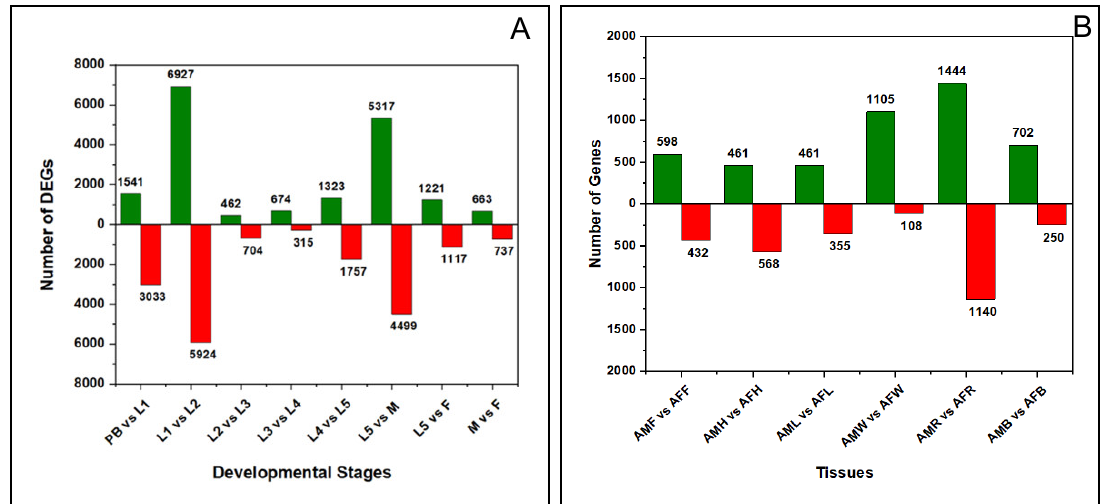
Figure 2. Bar graph of up- and down-regulated genes from pairwise comparisons. This figure shows the number of DEGs that are upregulated (green) and downregulated (red) across the ( A ) developmental stages of P. bremeri and ( B ) across the tissues of P. bremeri .